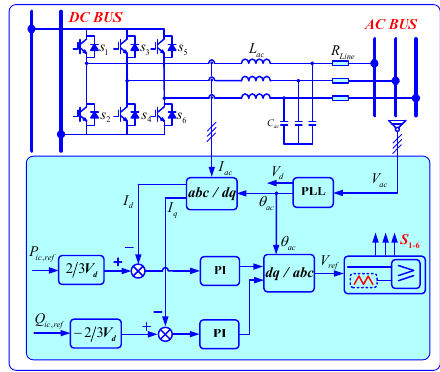
Figure 8. The final control diagram of the interlinking converter (IC).